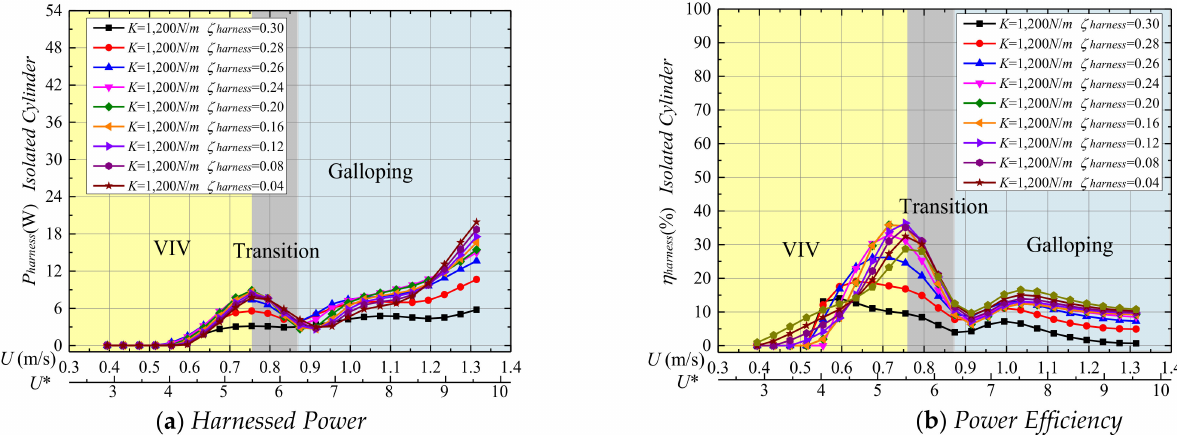
Figure 12. ( a ) Harnessed power and ( b ) power efficiency of isolated single cylinder; K = 1200 N/m; ζ harness =